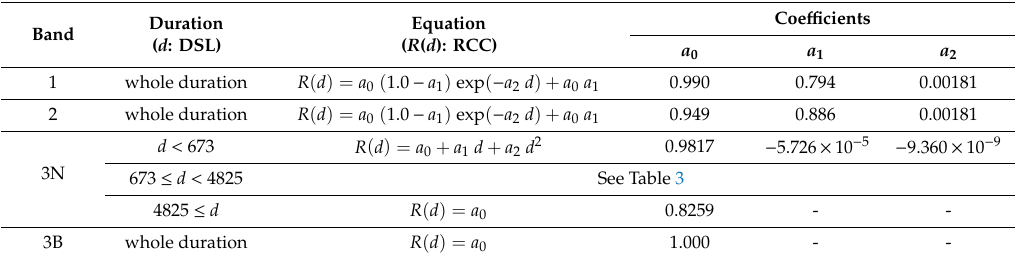
Table 2. Equations and parameters of the current radiometric degradation curves in the radiometric DB ver. 4 for ASTER VNIR bands.